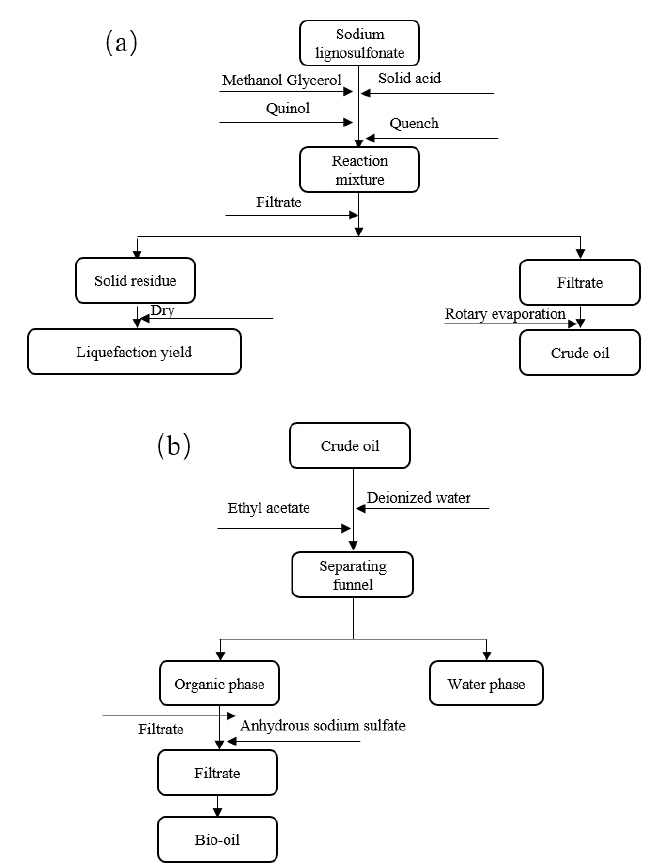
Figure 8. Flow chart of ( a ) lignin liquefaction and ( b ) product separation.